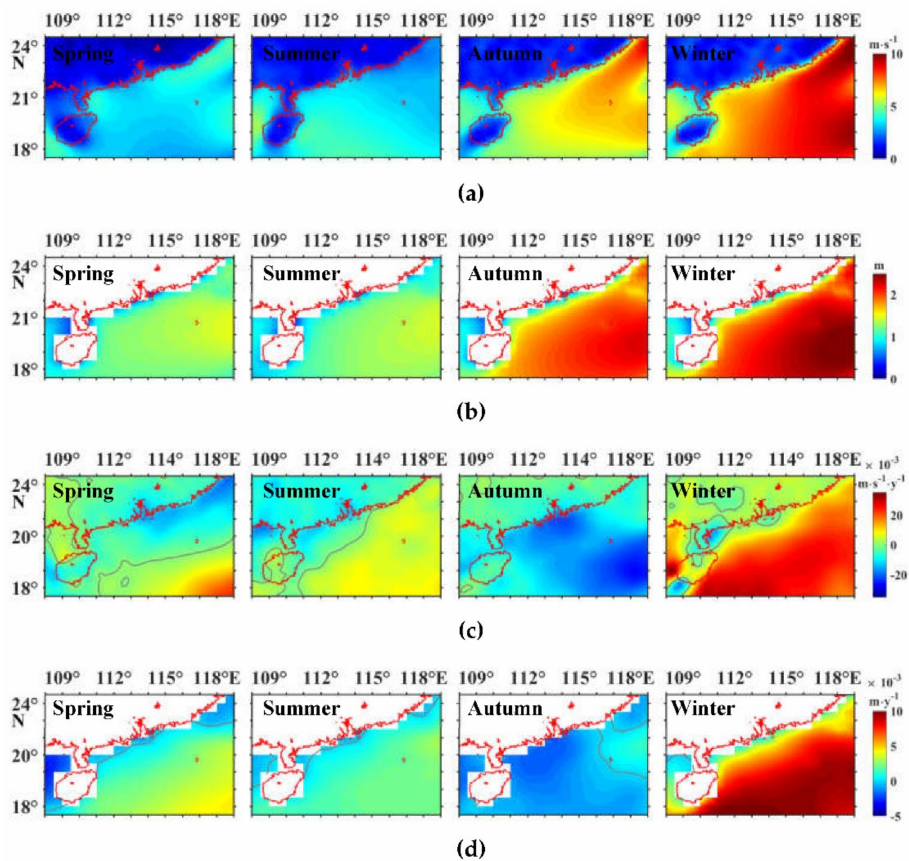
Figure 12. ( a ) Spatial distribution of the seasonal mean wind speed averaged from 1979 to 2019. ( b ) Spatial distribution of the seasonal mean significant wave height averaged from 1979 to 2019. ( c ) Trend of the seasonal mean wind speed. ( d ) Trend of the seasonal mean significant wave height. Grey represent are